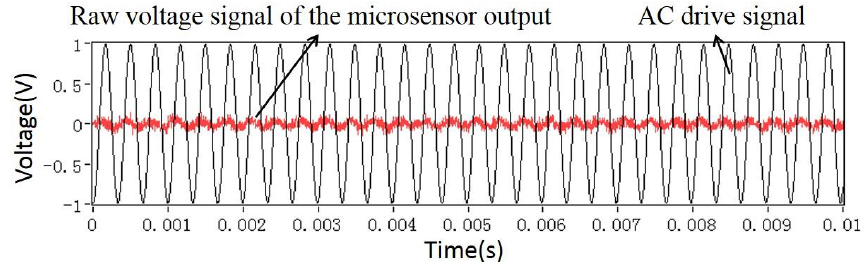
Figure 11. Raw voltage signal of the microsensor output and AC drive signal.